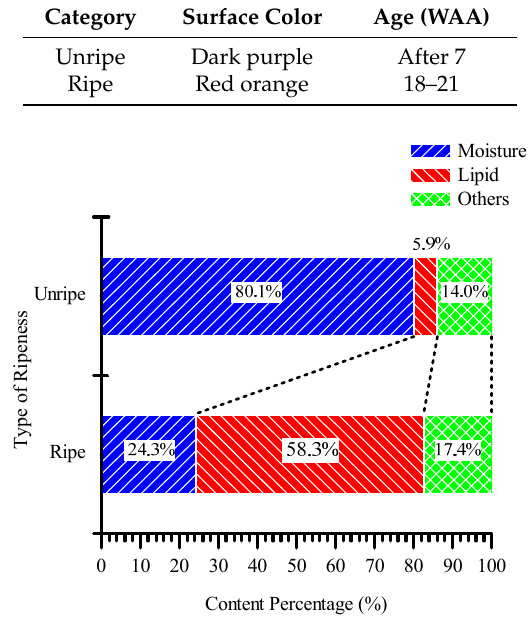
Figure 5. The percentage of content for unripe and ripe oil palm fruit.